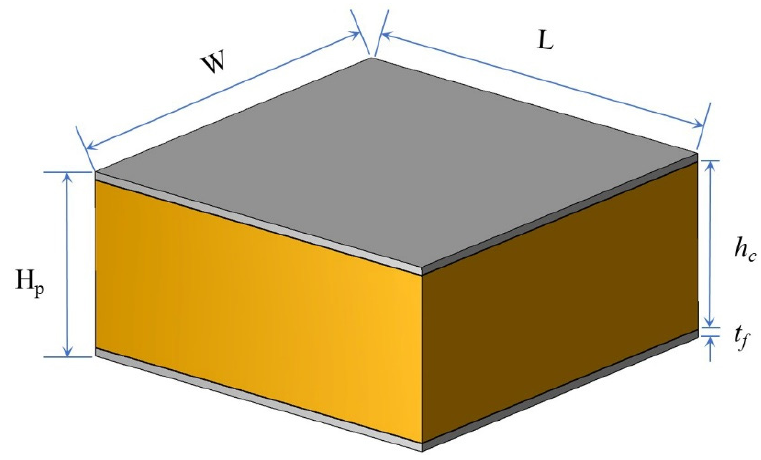
Figure 2. Structure of sandwich panel. Table 2. Parameters of Nomex honeycomb sandwich panel.